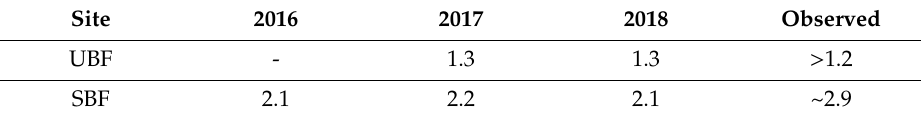
Table 4. The calculated thawing depth (in meters) using Stefan’s heat transfer